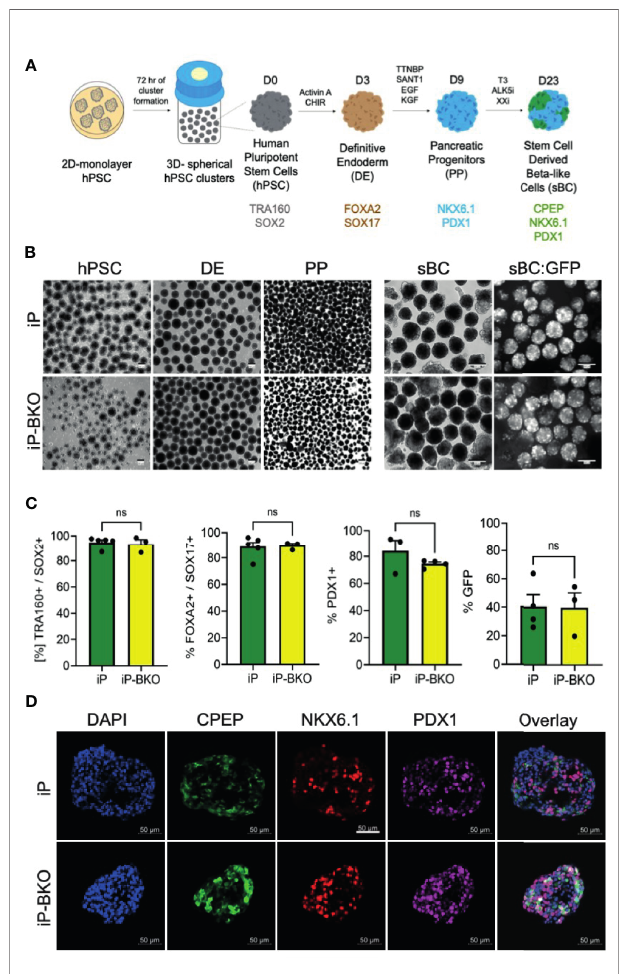
FIGURE 3 | iP and iP-BKO hPSC lines differentiate into sBC with similar ef fi ciencies. (A) Schematic of stepwise, suspension culture-based, direct differentiation approach for the generation of sBC clusters from hPSC. Critical induction molecules and gene markers at key differentiation stages are shown. (B) Representative bright fi eld images of differentiating hPSC clusters in bioreactors at key developmental stages (left panel). Live images of insulin promoter-driven GFP expression at sBC stage (right panel). Note the higher magni fi cation for sBC compared to earlier hPSC, DE and PE stages. All scale bars represent 200um. (C) Quanti fi cation of stage speci fi c marker expression for iP and iP-BKO differentiating clusters using fl ow cytometric analysis. Data is presented as SEM +/- percentage of positive cells for indicated markers. Unpaired student t test was performed with no signi fi cant changes denoted as ns. (D) Representative immuno fl uorescence images of sBC derived from iP and iP-BKO cell lines. Samples were stain for DAPI (blue), CPEP (green), NKX6.1 (red), and PDX1 (purple) are shown. Scale bar represents